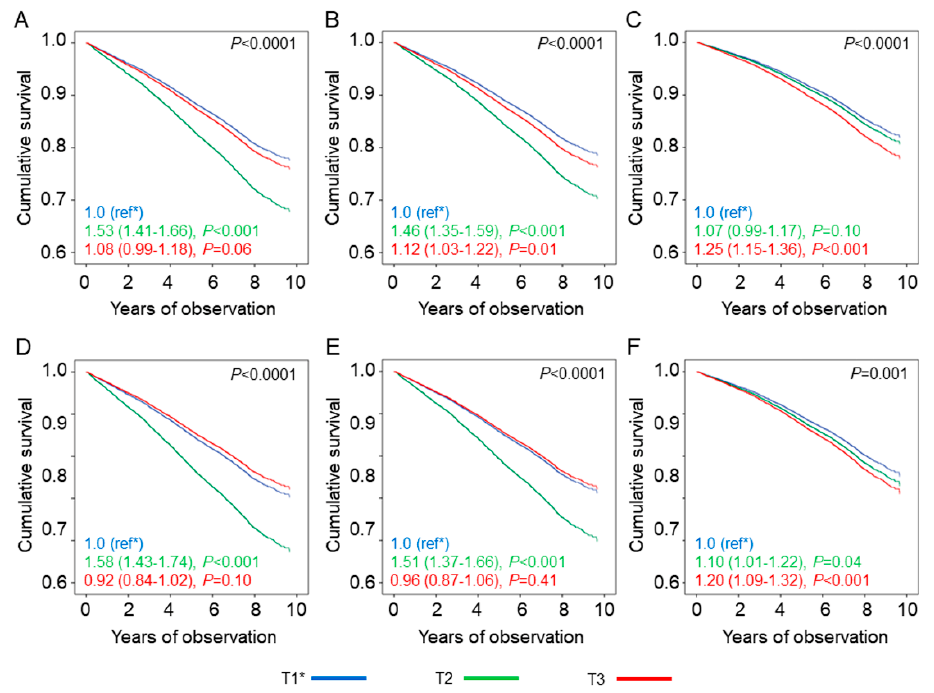
Figure 3. Mortality risk by HbA 1c target categories and use of agents causing hypoglycaemia. Cox proportional hazards regression according to HbA 1c target categories in the whole cohort ( A – C ) and among participants treated with agents causing hypoglycaemia ( D – F ), unadjusted ( A , D ) and adjusted for CVD risk factors ( B , E ), complications / comorbidities ( C , F ). HRs (95% CI) for mortality are shown for each HbA 1c target category. HbA 1c = haemoglobin A 1c ; HR = hazard ratio; CI = confidence interval; T1 = HbA 1c on-target ( ≤ 0.5% below or above personalized goal); T2 = HbA 1c below-target (>0.5% below personalized goal); T3 = HbA 1c above-target (>0.5% above personalized goal). Table 3. Baseline clinical features of study participants by HbA 1c target categories.